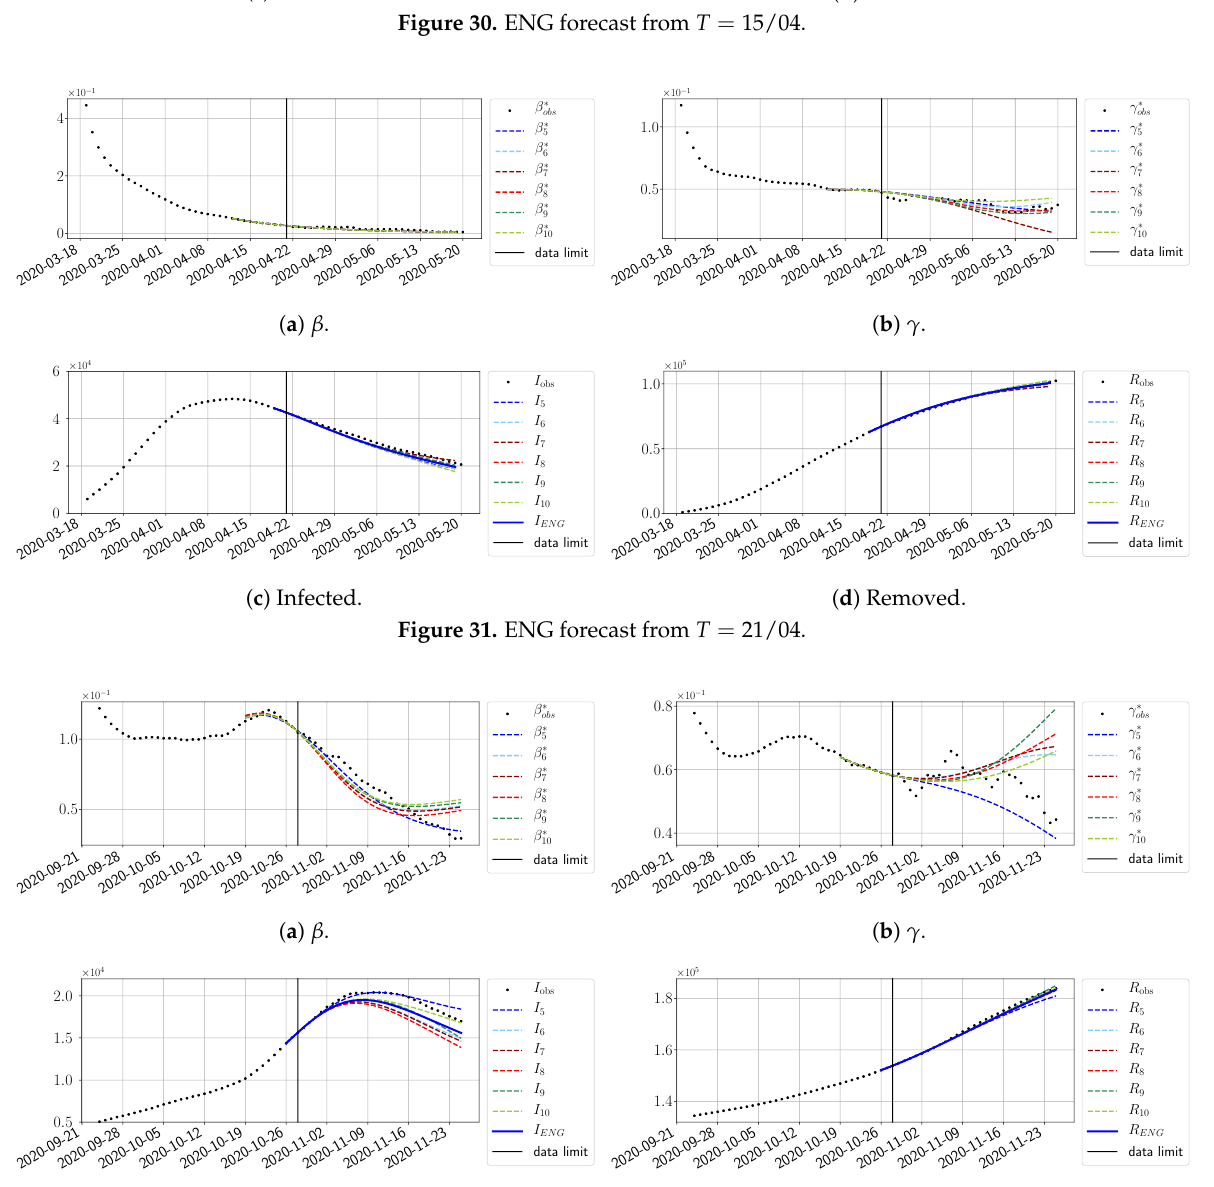
Figure 32. ENG forecast from T =